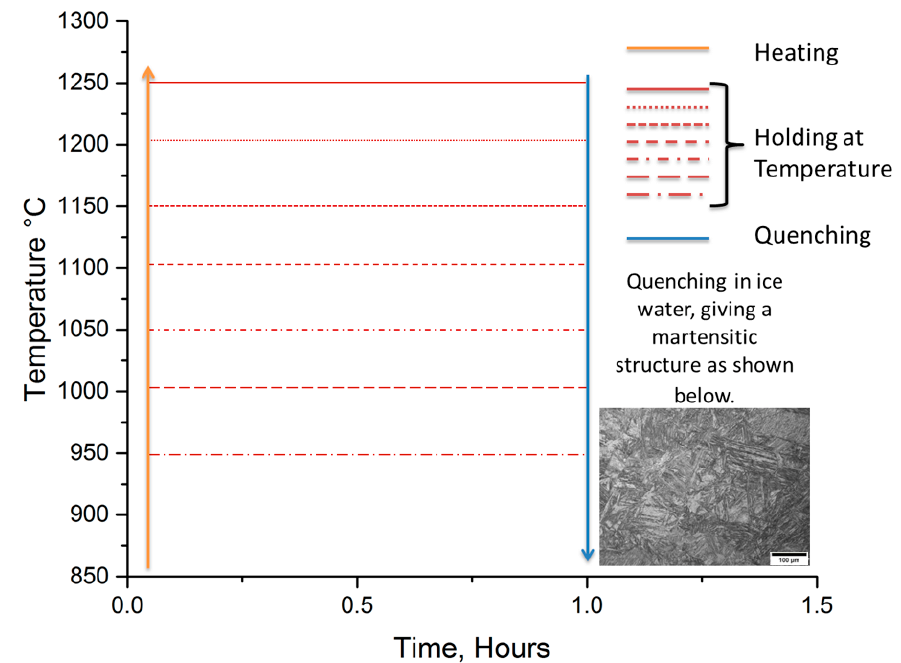
Figure 1. Schematic of the reheating temperature and quenching process used for the three carbon steels with varying niobium concentration to examine the microstructural evolution. Holding time was one hour, and heat treatments were carried out in an argon atmosphere.